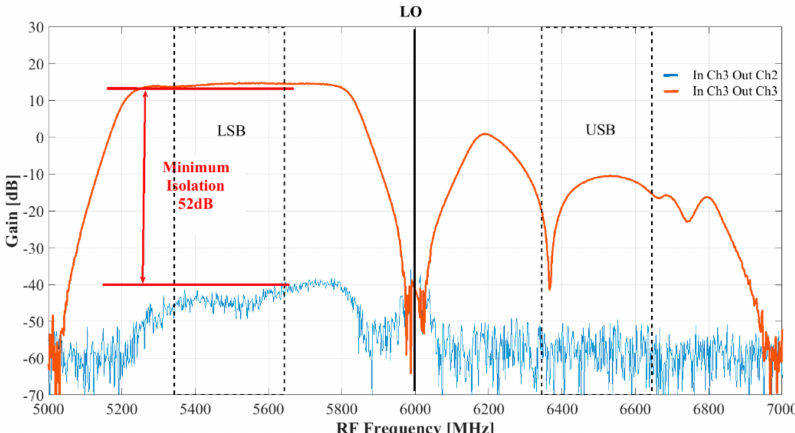
Figure 20. Measured board #2 transmission from two contiguous channels (channel 3 and channel 2) for filter BPF A with LO set at 6 GHz: the ratio between the signal gains (LSB gains) provides the channel-to-channel isolation. The board was integrated into the module with mechanical support.